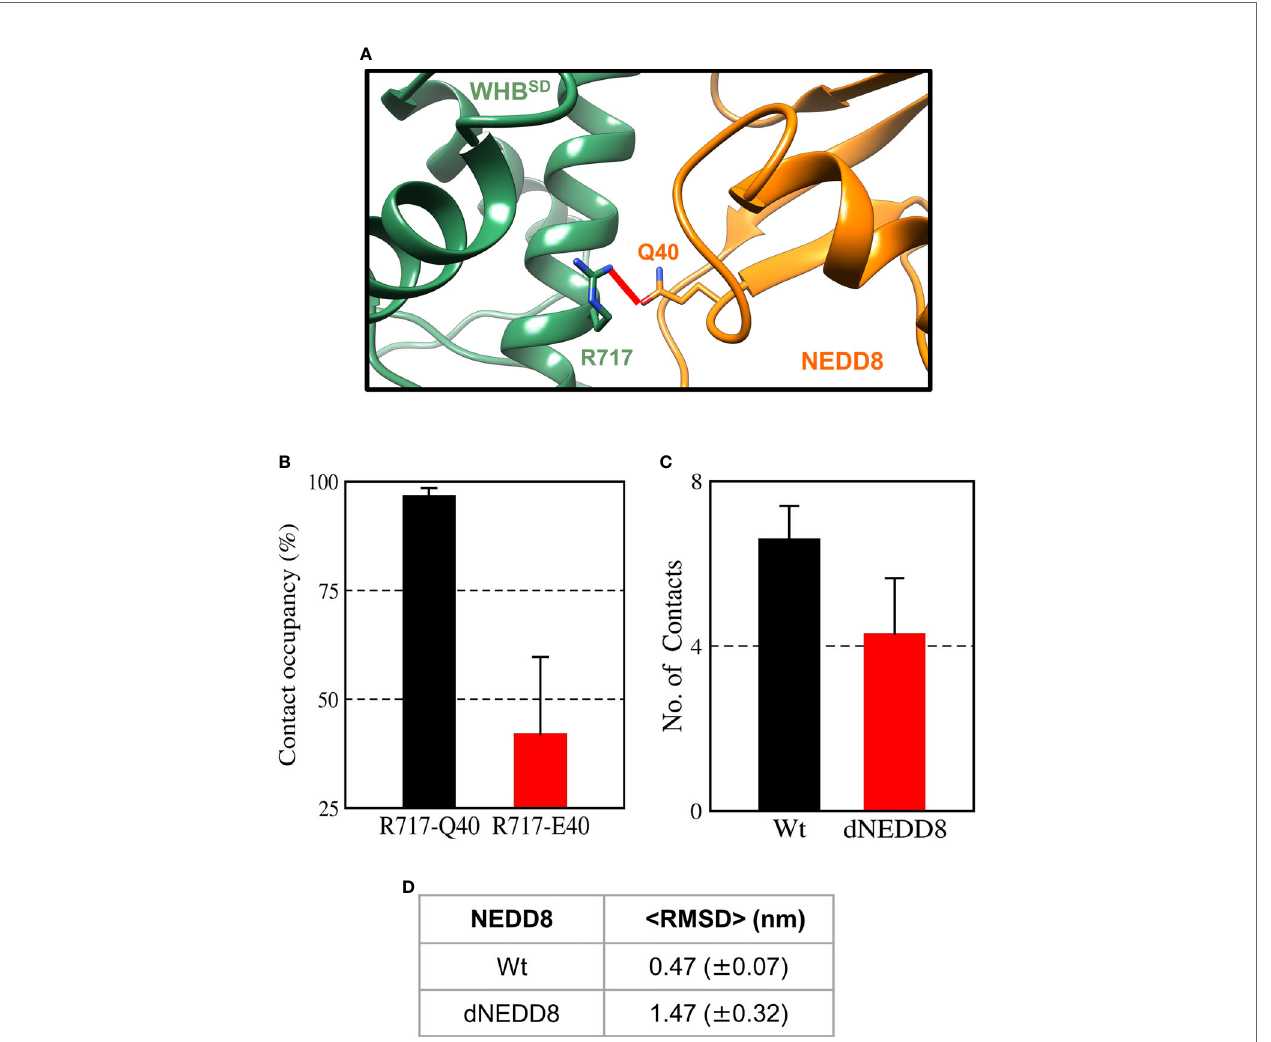
FIGURE 8 | An intermolecular salt-bridge involving E40 destabilizes the Cul1-WHB SD ~NEDD8 complex. (A) Relative positions of R717 and Q40 in the Cul1- WHB SD ~NEDD8. The red line connects the N h 1 atom of R717 to the O ϵ atom of Q40 and has a length of 0.41 nm. The distance between the atoms drops below 0.32 nm in NEDD8-wt simulations, indicating a hydrogen bond formation. (B) Contact occupancies of R717-Q40 hydrogen bond, and R717-E40 salt-bridge were calculated using cutoffs of 0.32 and 0.5 nm, respectively. Mean ± std. Error is calculated for over three independent 200 ns trajectories. (C) Mean ± std error of the number of contacts formed between NEDD8 (I36/L71) and Cul1-WHB SD (helix-29) sidechains using a cutoff of 0.45 nm. (D) Average RMSDs of Cul1- WHB SD ~NEDD8 complexes over three independent 200 ns trajectories. ± One std. Error is indicated in (